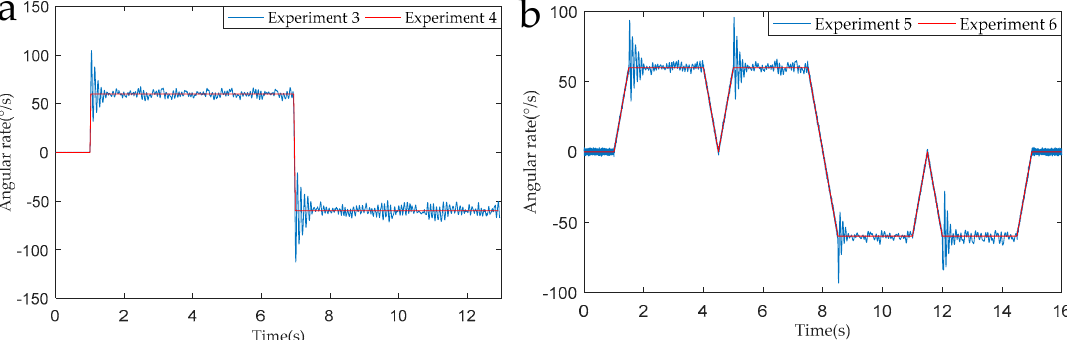
Figure 12. ( a ) Modulation angular rates of Experiment 3 and Experiment 4. ( b ) Modulation angular rate of Experiment 5 and Experiment 6.